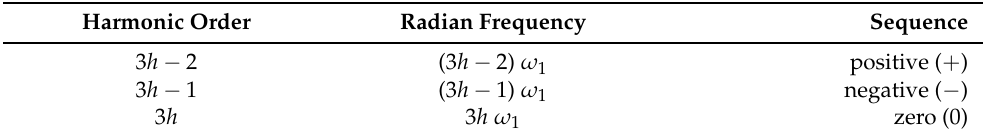
Table 1. Sequences for the different harmonic orders in a balanced three-phase system for h = 1,2, . . . , ∞